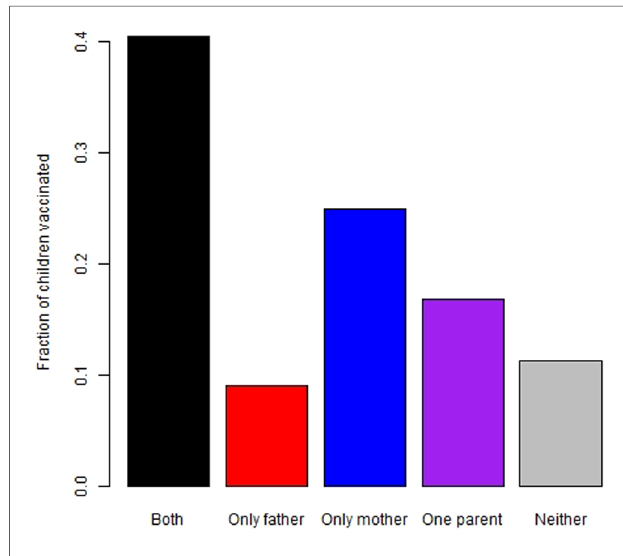
FIGURE 2 Children ’ s vaccination rates by parental vaccination status black – both parents vaccinated; Red – only father vaccinated; blue – only mother vaccinated; violet – one parent vaccinated; grey- neither parent